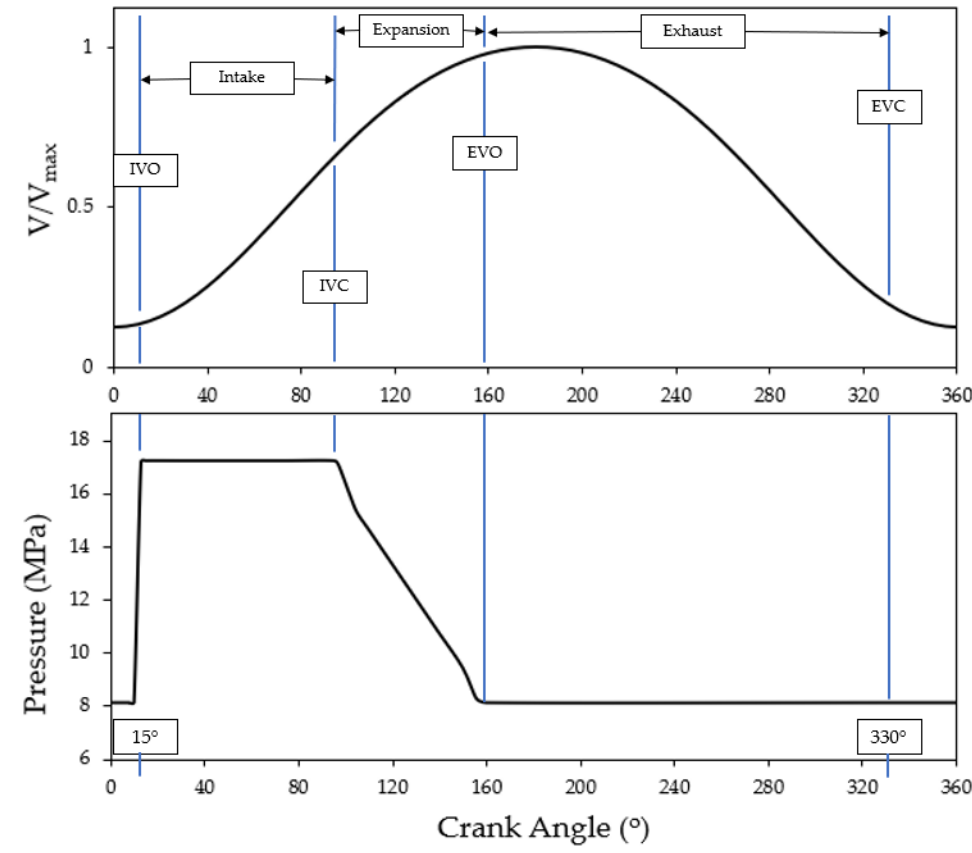
Figure 7. Sequence of events in the sCO 2 engine operating cycle.